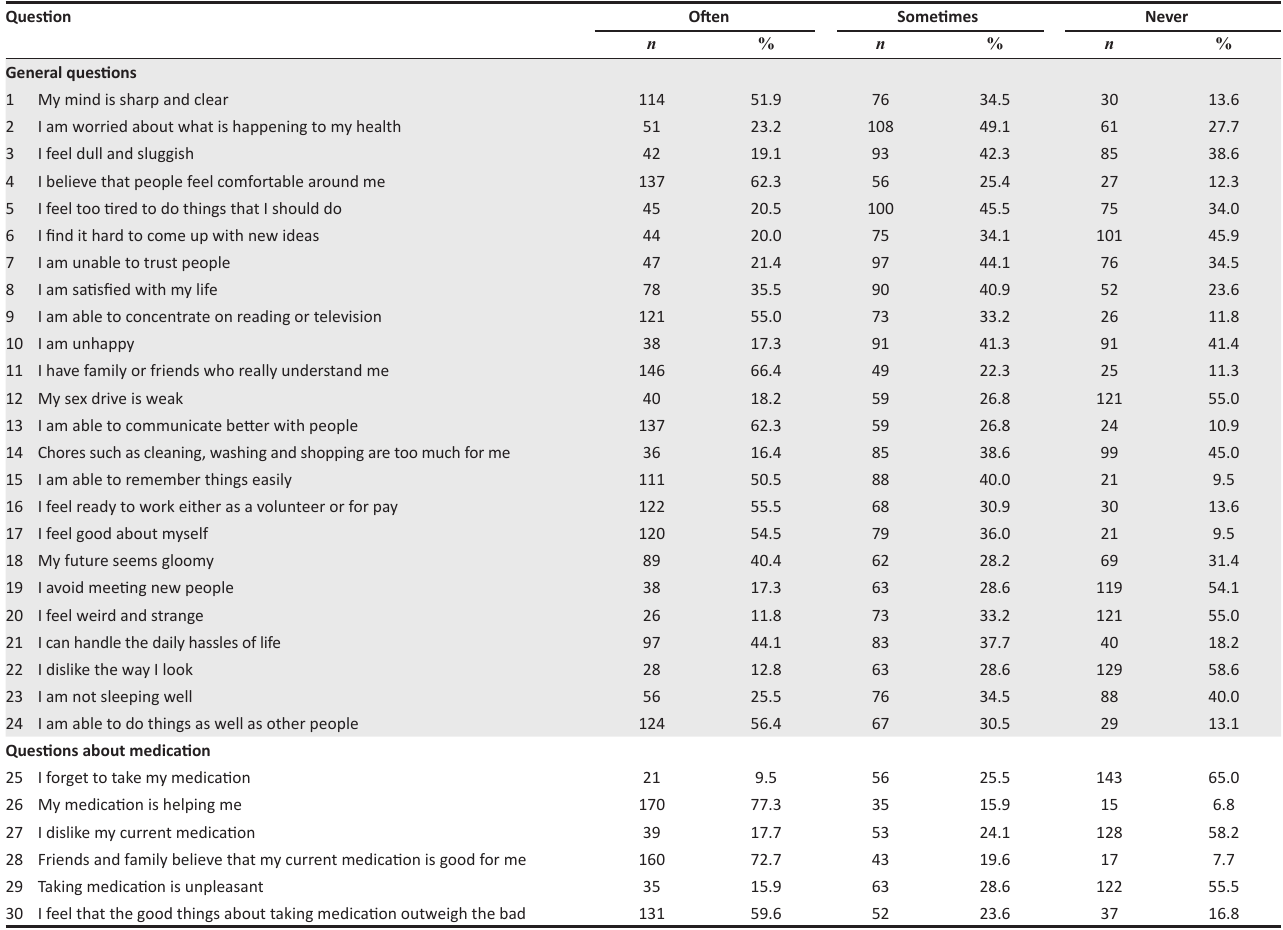
TABLE 1: Mean scale score (at T 1 and T 2 ) and frequency of item scale of respondents at T 1